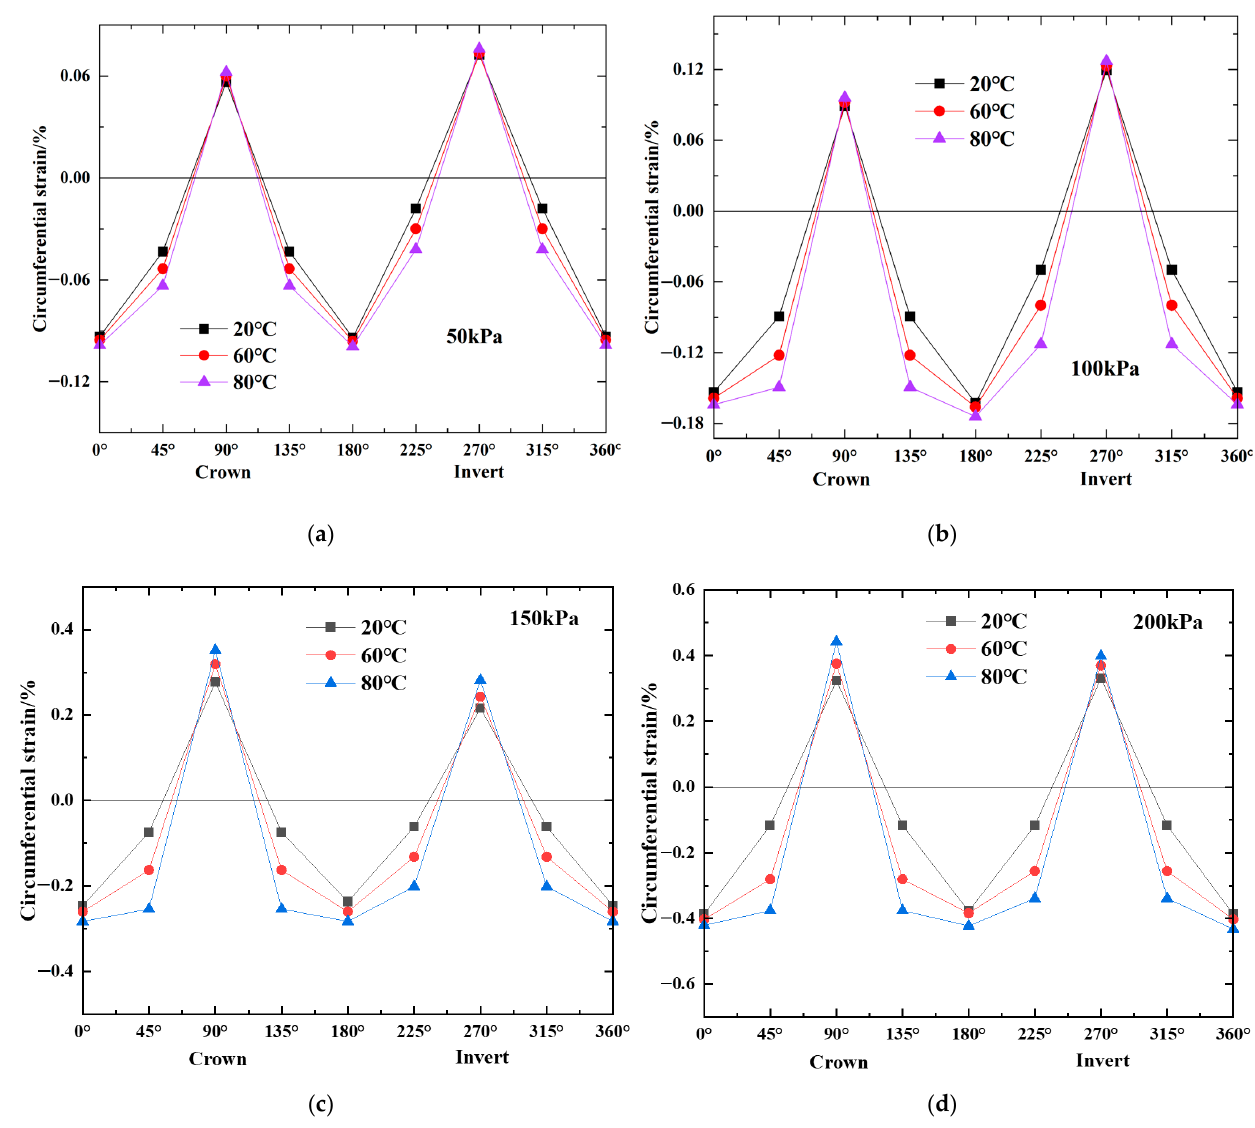
Figure 3. Strain profiles for the load test versus temperature: ( a ) 50 kPa vertical pressure; ( b ) 100 kPa vertical pressure; ( c ) 150 kPa vertical pressure; ( d ) 200 kPa vertical pressure.